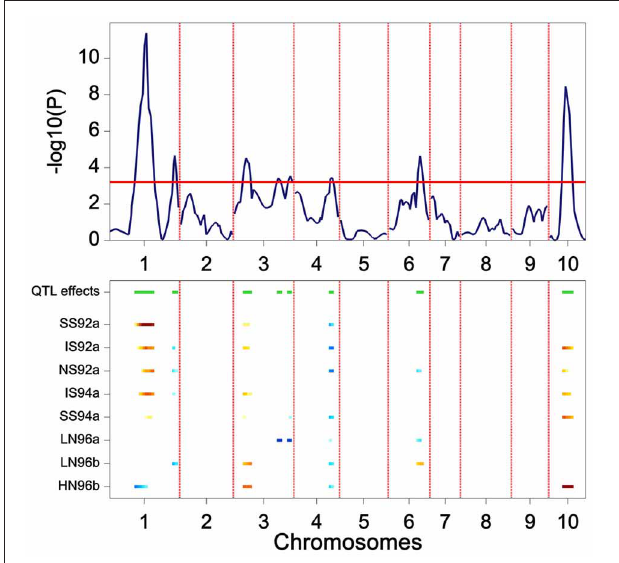
FIGURE 5 | Plot produced by a SIM QTL scan in a maize F2 population. The upper panel shows the P value of the Wald test (on a –log10 scale) for the effect of a QTL along the chromosomes (solid line). The horizontal line indicates a threshold value for significance. The lower panel gives an indication of magnitude of QTL effects (higher intensity, larger effect), and parental line contributing the superior allele (blue, maternal; red, parental